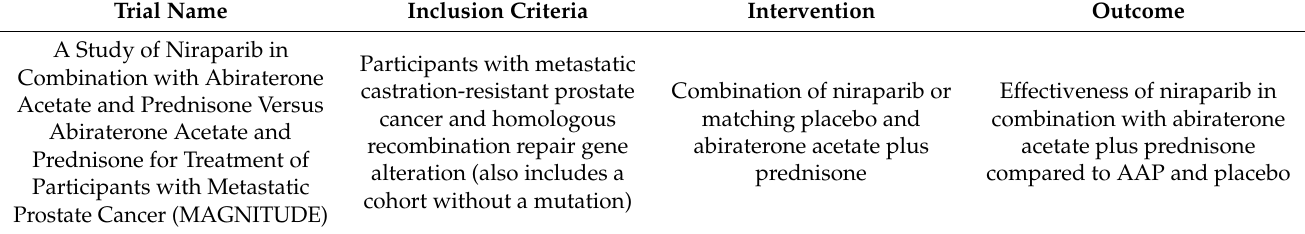
Table 2. Ongoing clinical trials for metastatic prostate cancer that may benefit men with high-risk germline